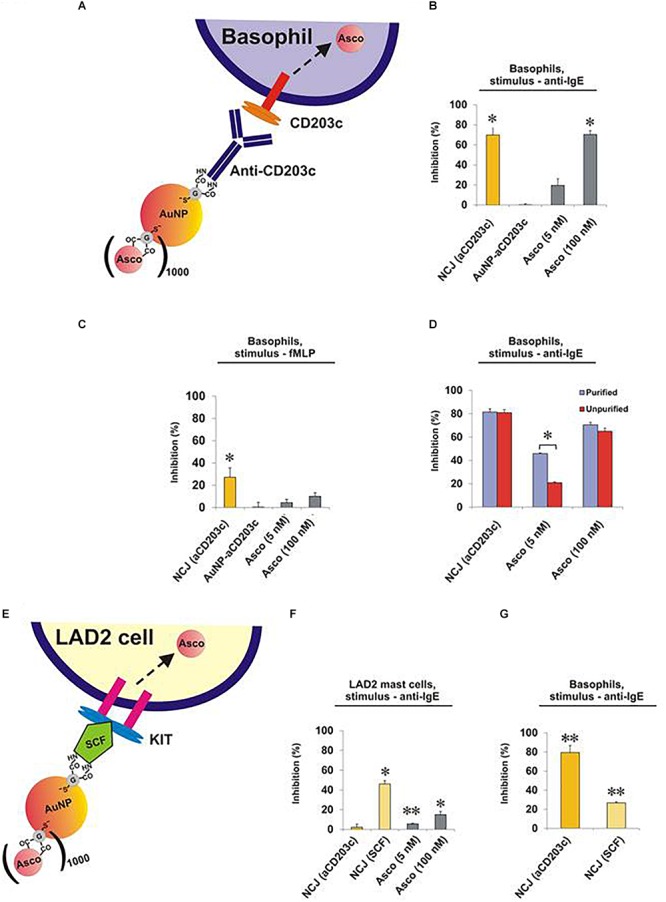
Effect of NCJs on histamine release from human basophils and LAD2 mast cells. Cells were preincubated for 15 min either with NCJs, ascomycin or buffer alone before stimulation for 30 min, after which histamine releases were assessed. All results are shown as percentage inhibition of histamine release ± SEM. ∗ and ∗∗ denote significant differences from control using a paired Student’s t-test (p < 0.05 or p < 0.01, respectively). Panel A Scheme illustrating the interaction of a NCJ containing anti-CD203c with a human basophil and subsequent ascomycin delivery. Panel B Basophils stimulated with anti-IgE (n = 4). Results were first corrected from spontaneous releases (5.4 ± 1.1%) and percentage inhibition calculated from net anti-IgE-induced release in the absence of NCJs or inhibitors (25.3 ± 4.1%). Panel C Basophils stimulated with fMLP (n = 4). Results were first corrected from spontaneous releases (4.2 ± 1.2%) and percentage inhibition calculated from net fMLP-induced release in the absence of NCJs or inhibitors (31.6 ± 4.0%). Panel D Comparison of the inhibitory effects of NCJs and ascomycin alone in purified (>90% pure) and unpurified (<2% pure) human basophils stimulated with anti-IgE. Spontaneous histamine releases (4.6 ± 0.5% for purified basophils, 3.2 ± 0.7% for unpurified basophils) were first subtracted and the results expressed as percentage inhibition of histamine release caused by anti-IgE alone (net releases were 14 ± 2.7% for purified basophils, 14.2 ± 2.5% for unpurified basophils) (n = 8). Panel E Scheme illustrating interaction of a NCJ containing SCF with LAD2 mast cell and subsequent ascomycin delivery. Panel F Effect of NJCs on histamine release from LAD2 cells stimulated with anti-IgE (n = 6). Results were first corrected from spontaneous releases (15.7 ± 0.5%) and percentage inhibition calculated from net anti-IgE-induced release in the absence of NCJs or inhibitors (15.9 ± 0.7%). Panel G Effect of different NJCs on histamine release from purified human basophils stimulated with anti-IgE. Results were first corrected from spontaneous releases (4.0 ± 0.3%) and percentage inhibition calculated from net anti-IgE-induced release in the absence of NCJs or inhibitors (10.6 ± 1.0%).